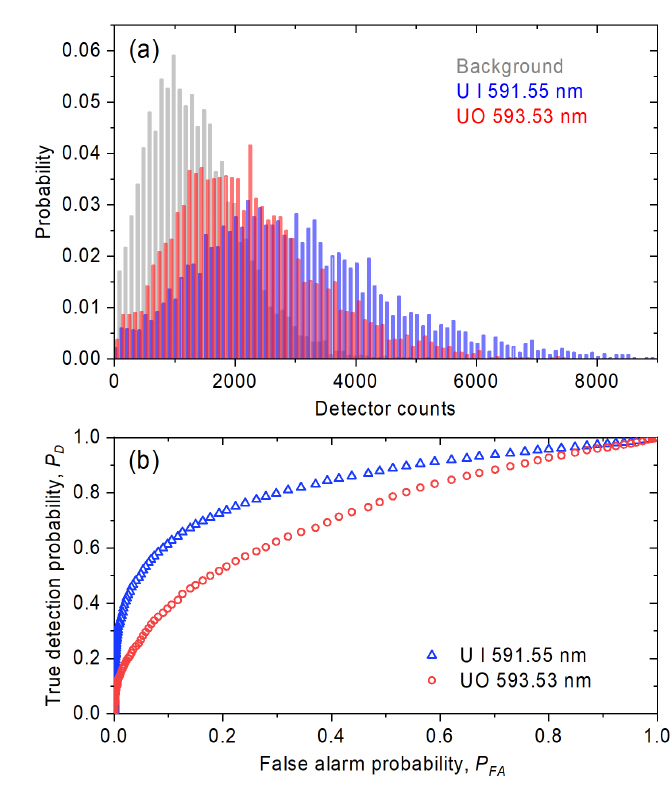
Figure 7. ( a ) Normalized probability of occurrence is shown in the histogram for each single laser shot. ( b ) Detection and false alarm probabilities compared in the receiver operating characteristic (ROC)